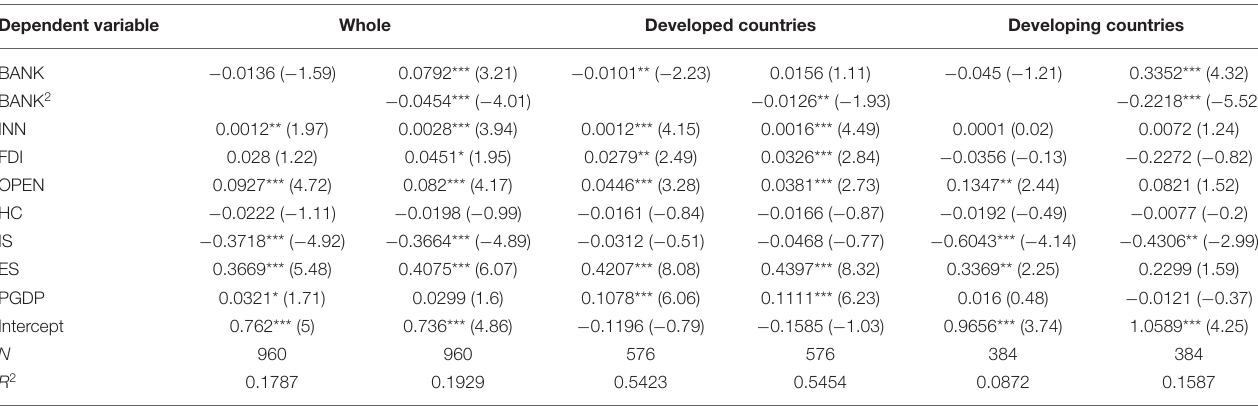
TABLE 3 | Estimation of the impact of bank development on GTFP.